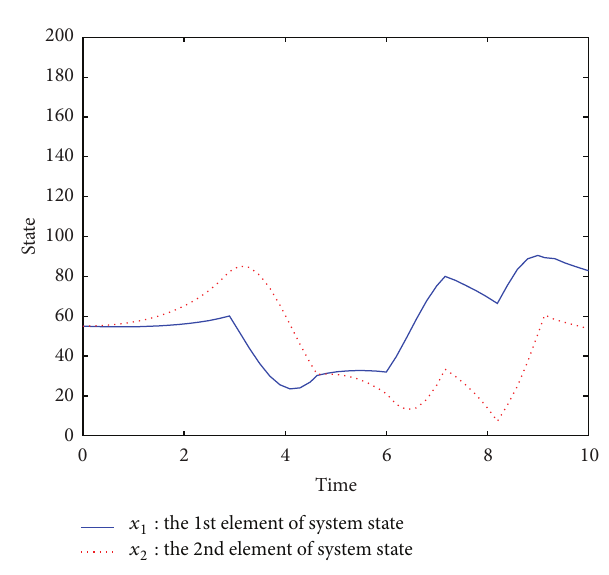
Figure 2: The figure of system